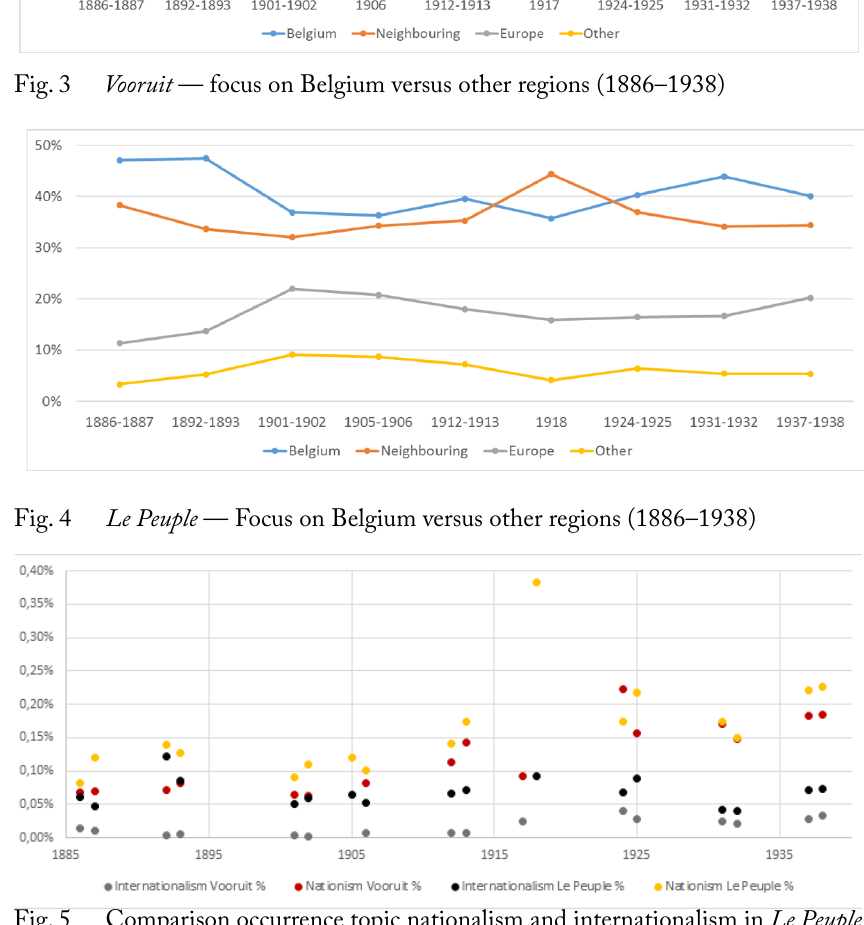
Fig. 5 Comparison occurrence topic nationalism and internationalism in Le